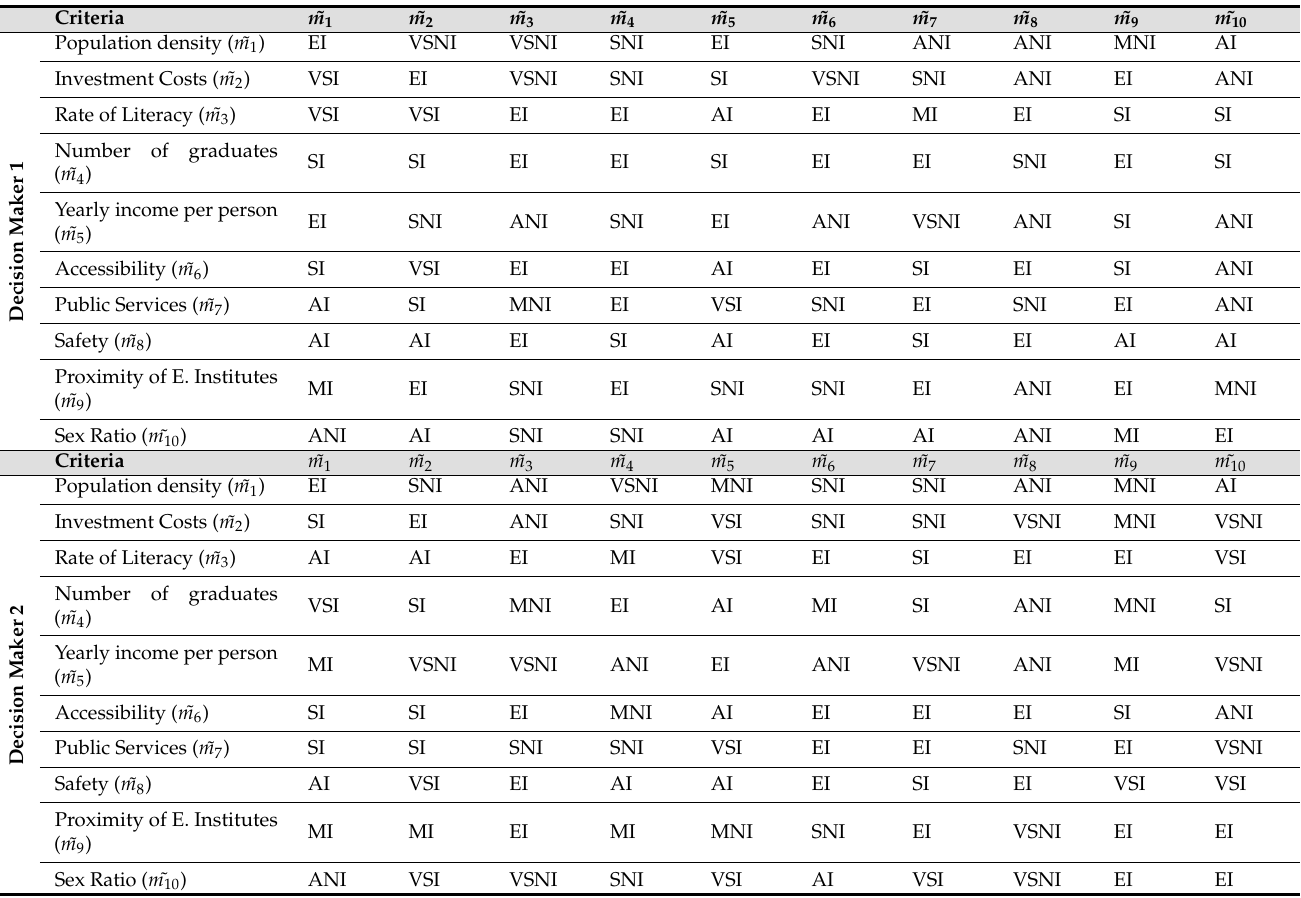
Table 14. Comparison matrix in linguistic term between criterion’s by the three